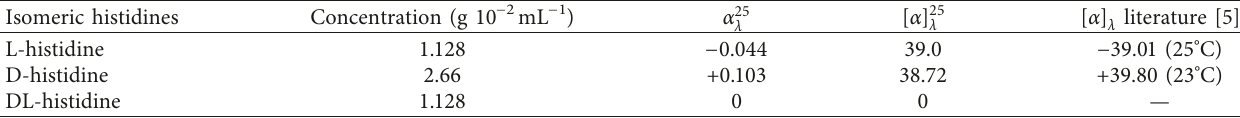
Table 1: Polarimetric data of histidine stereoisomers.